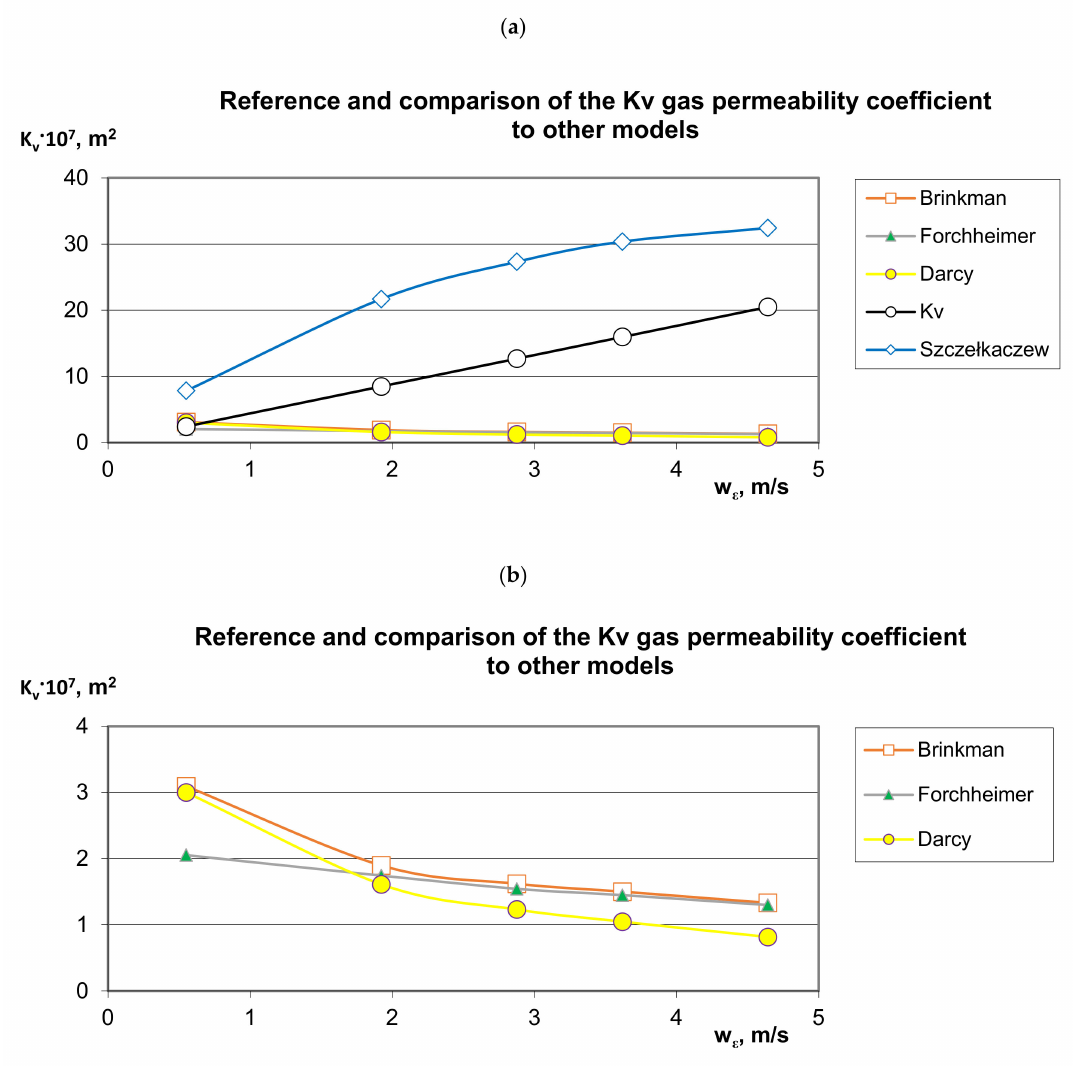
Figure 7. Reference and comparison of the K v gas permeability coefficient to other models—distribution of experimental points characterizing the gas permeability of a 20 mm × 20 mm × 20 mm cubic polyamide bed with respect to the measured gas flow velocity depending on the averaged direction of flow XYZ: ( a ) general chart and ( b ) fragment of the